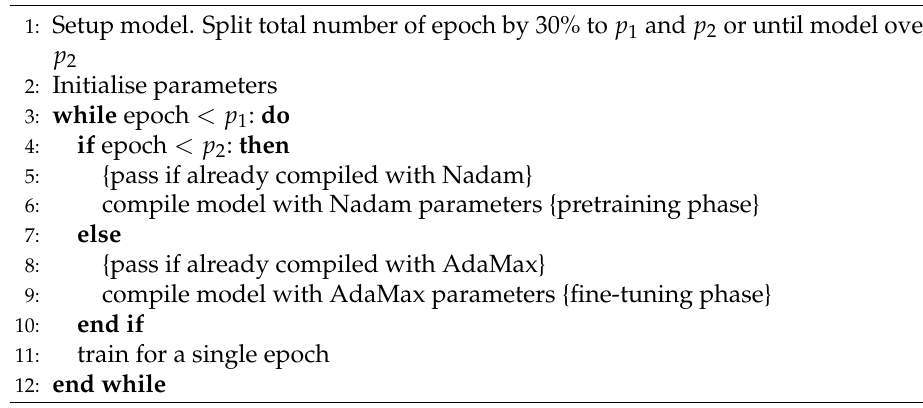
Algorithm 6 Ensemble optimisation training